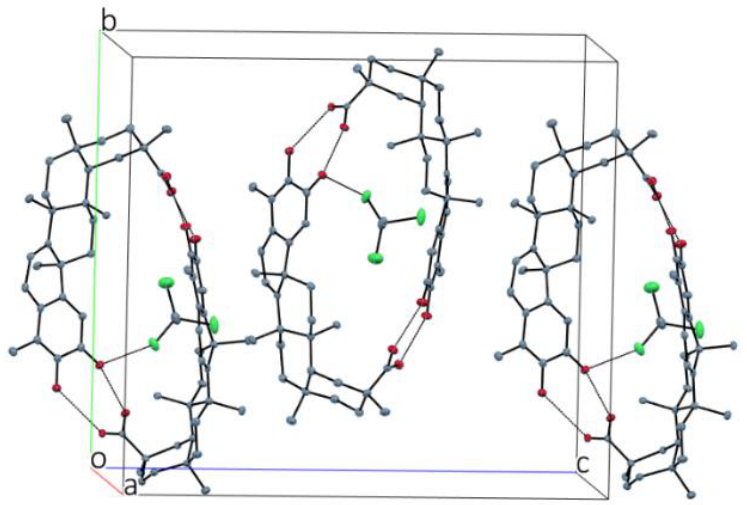
Figure 2. Celastrol molecule showing the conformation of the individual rings: planar for the methide quinone ring A on the left; envelope with C6 out of plane for adjacent ring B; remaining three rings are in chair conformation. H atoms are not shown for clarity. Figure 3. Asymmetric unit dimeric structure with chloroform solvent showing H-bond and halogen bond distances. H atoms not shown for clarity.